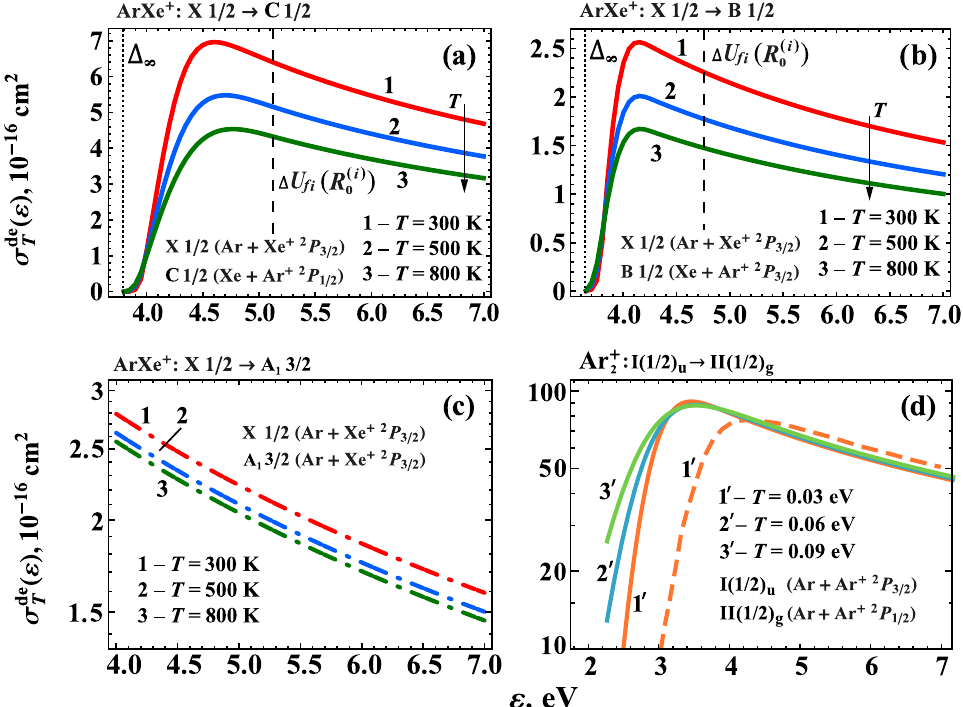
Figure 3. ( a , b ) Cross sections of dissociative excitation, σ de , of ArXe + by electrons via transitions T to charge transfer terms: ArXe + ( X 1/2 ) + e → ArXe + ( C 1/2 ) + e → Xe + Ar + ( 2 P 1/2 ) + e (( a ), A-type transitions) and ArXe + ( X 1/2 ) + e → ArXe + ( B 1/2 ) + e → Xe + Ar + ( 2 P 3/2 ) + e (( b ), B- type transitions) at gas temperatures T = 300, 500, 800 K. ( c ) Cross sections of dissociative excita- tion of ArXe + via non-adiabatic ArXe + ( X 1/2 ) + e → ArXe + ( A 1 3/2 ) + e → Ar + Xe + ( 2 P 3/2 ) + e transitions at T = 300, 500, 800 K. ( d ) Cross sections of process (1) of homonuclear ions Ar + via 2 ( I 1/2 u ) + e → Ar + ( II 1/2 g ) + e → Ar + Ar + ( 2 P ) + e transitions at T = 0.03, 0.06, and 0.09 Ar + 1/2 2 2